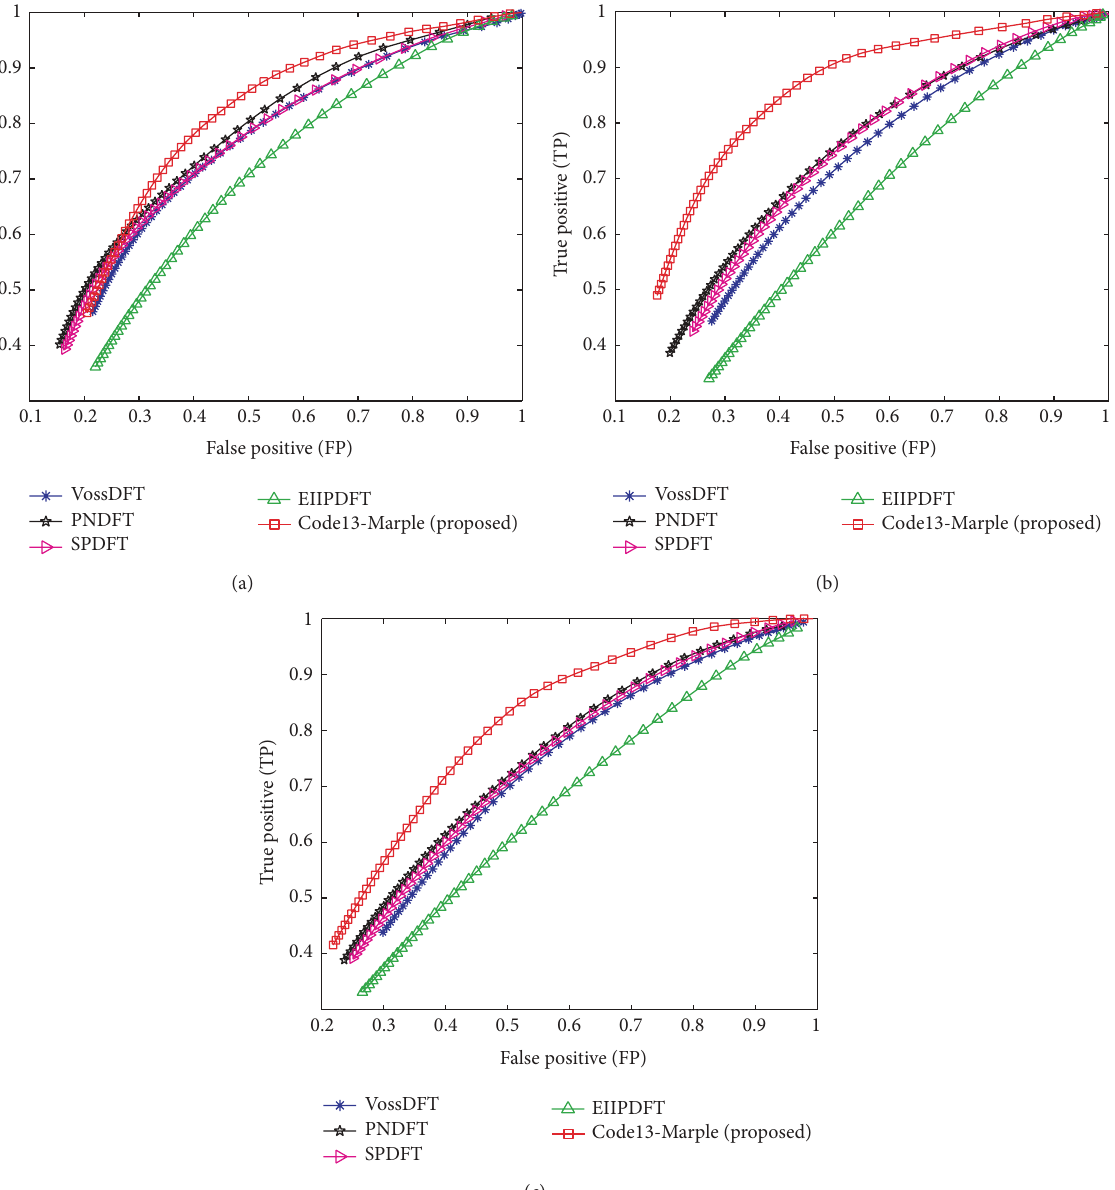
Figure 9: ROC curves of different techniques for three benchmark datasets. (a) The ROC curves of five methods (VossDFT, EIIPDFT, SPDFT, PNDFT, and Code13-Marple) for GENSCAN65 datasets. (b) The ROC curves of five methods for HMR195 datasets. (c) The ROC curves of five methods for BG570